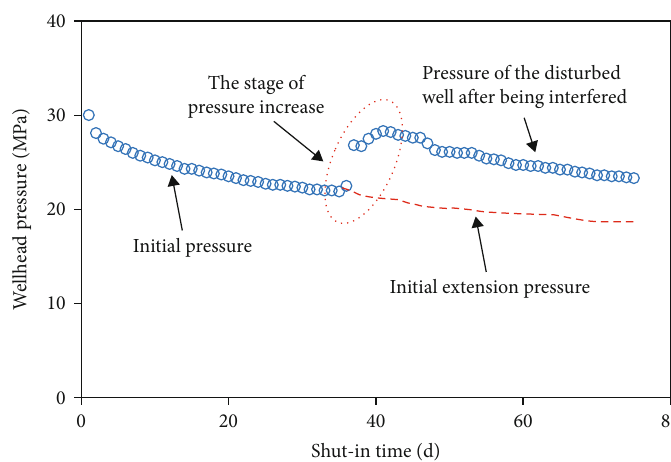
Figure 3: The schematic of the di ff erential pressure calculation.